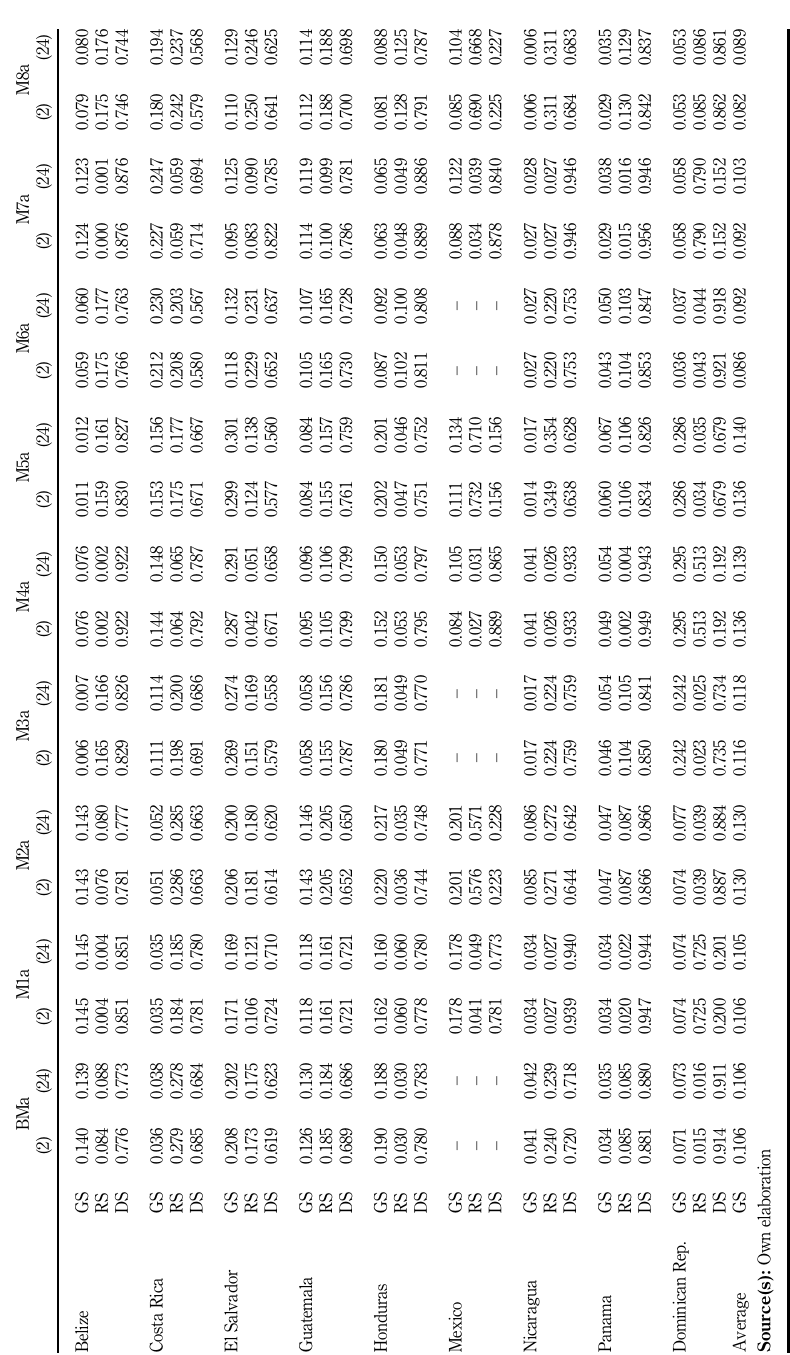
Table 4. Variance decomposition in alternative